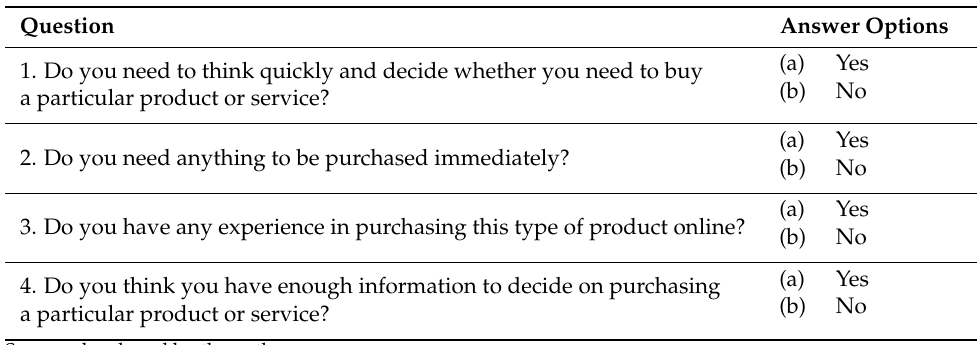
Table 4. Scoring chart for the External Influence